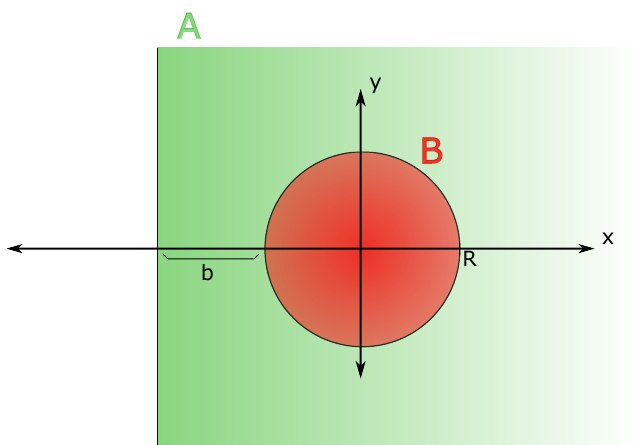
Figure 7 . Diagram of the spatial regions A and B considered for a (cid:12)xed time and two spatial dimensions. The parameter b must verify b (cid:21) 0 so that B (cid:18) A